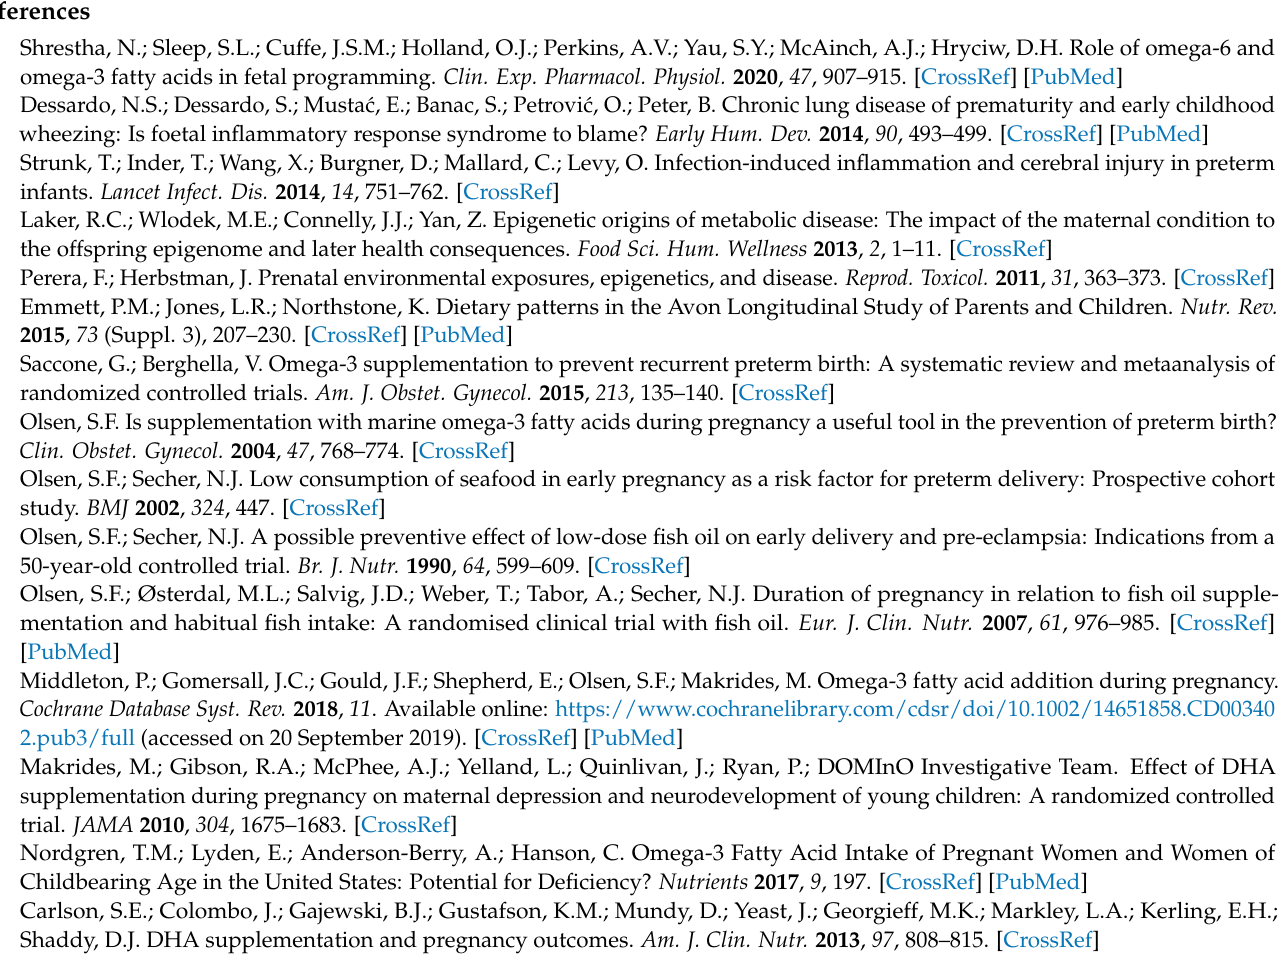
Dessardo, N.S.; Dessardo, S.; Mustać, E.; Banac, S.; Petrović, O.; Peter, B. Chronic lung disease of prematurity and early